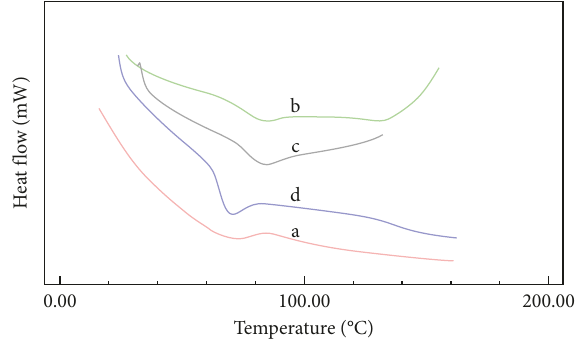
0.00 Figure 8: DSC curves of (a) poly(DEAMSt0.49-co-BMA), (b) poly(DEAMSt0.49-co-BMA)-Co, (c) poly(DEAMSt0.49-co-BMA)- Ni, and (d)